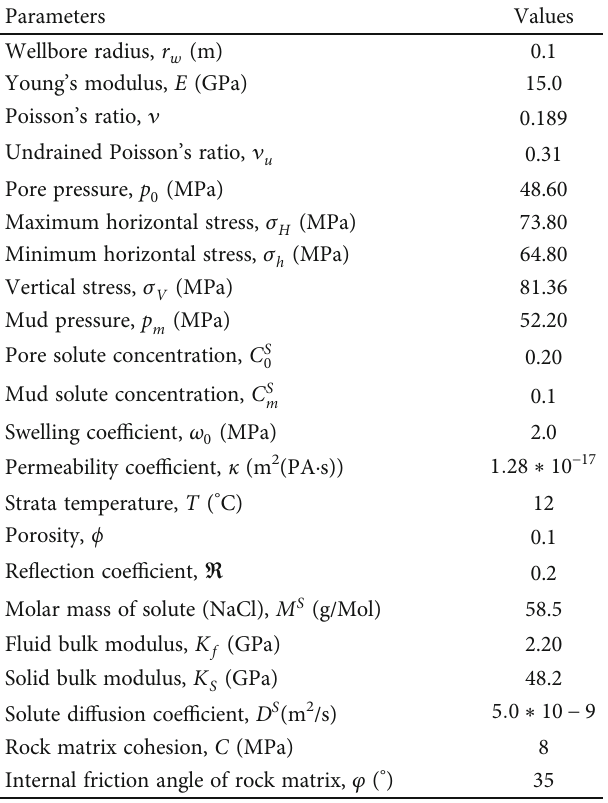
Table 6: Parameters used in the wellbore stability analysis considering the pore pressure and stress change due to the chemical e ff